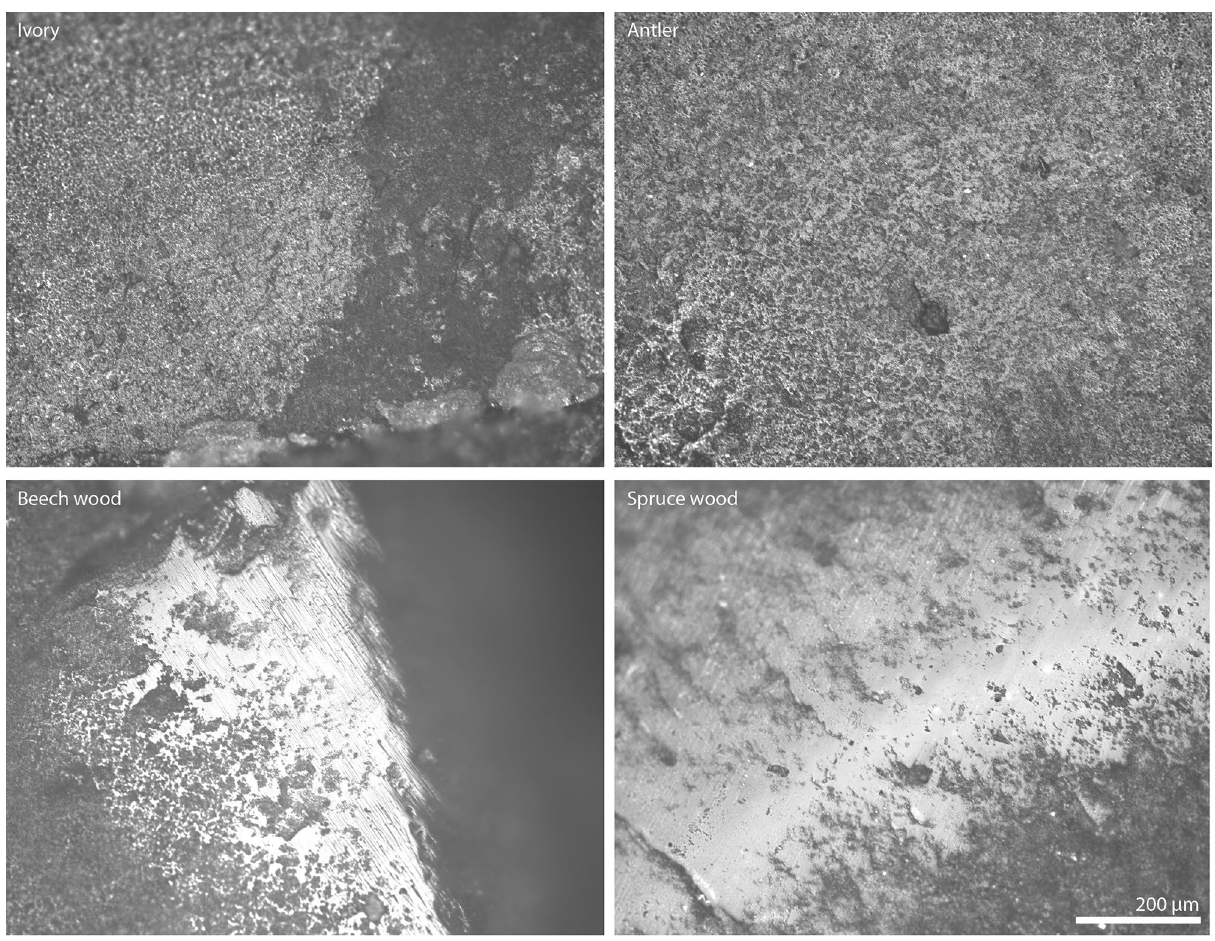
Figure 2. Reflection micrographs of use-wear polish on various samples analysed after the